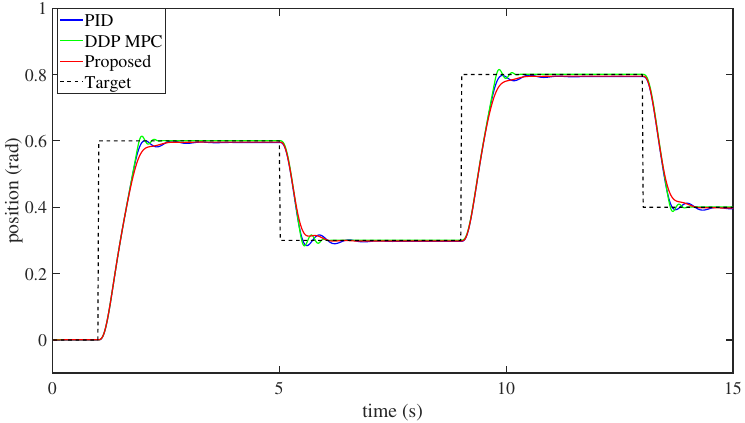
Figure 9. The target tracking process of different